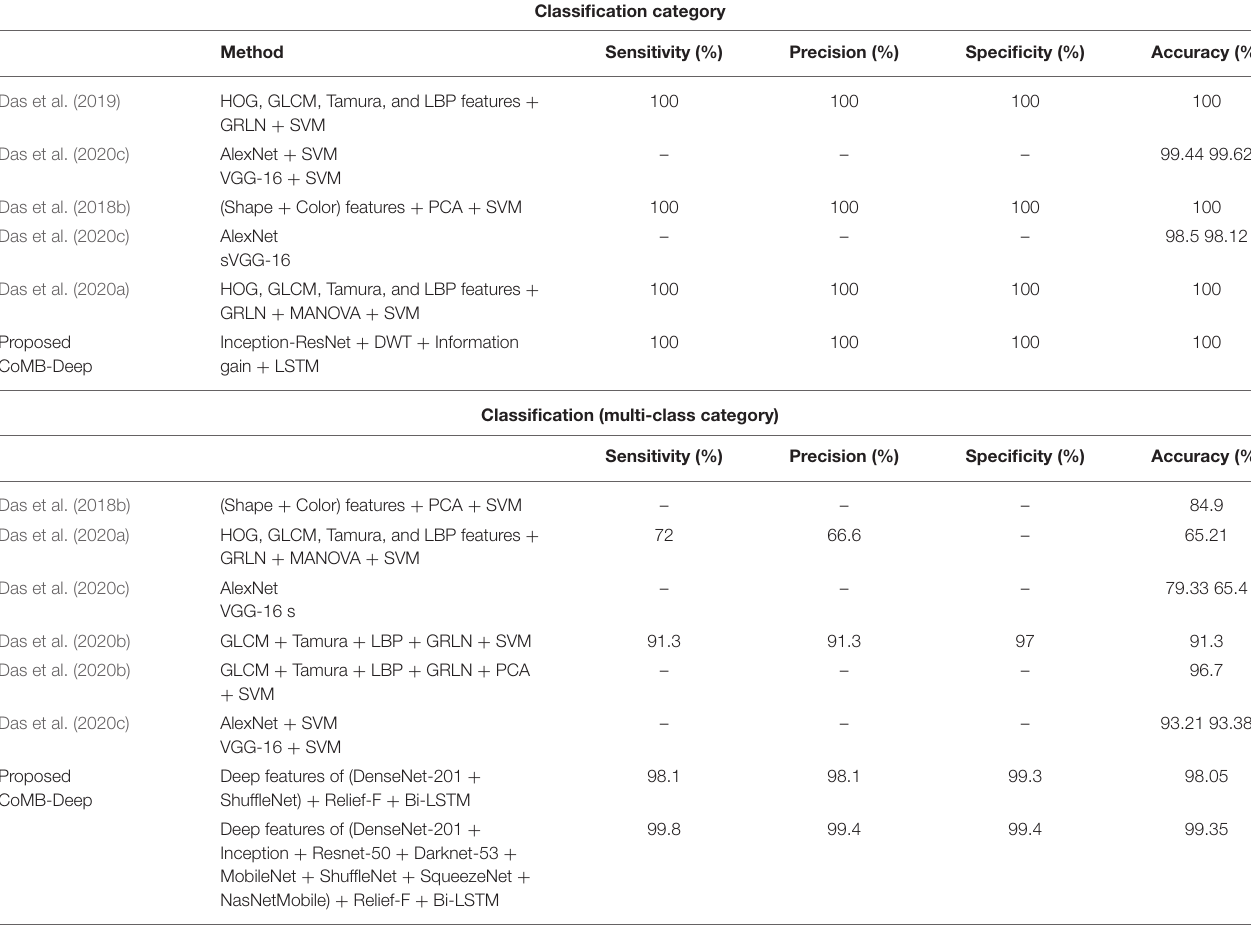
TABLE 7 | A comparison between CoMB-Deep and related studies using the same